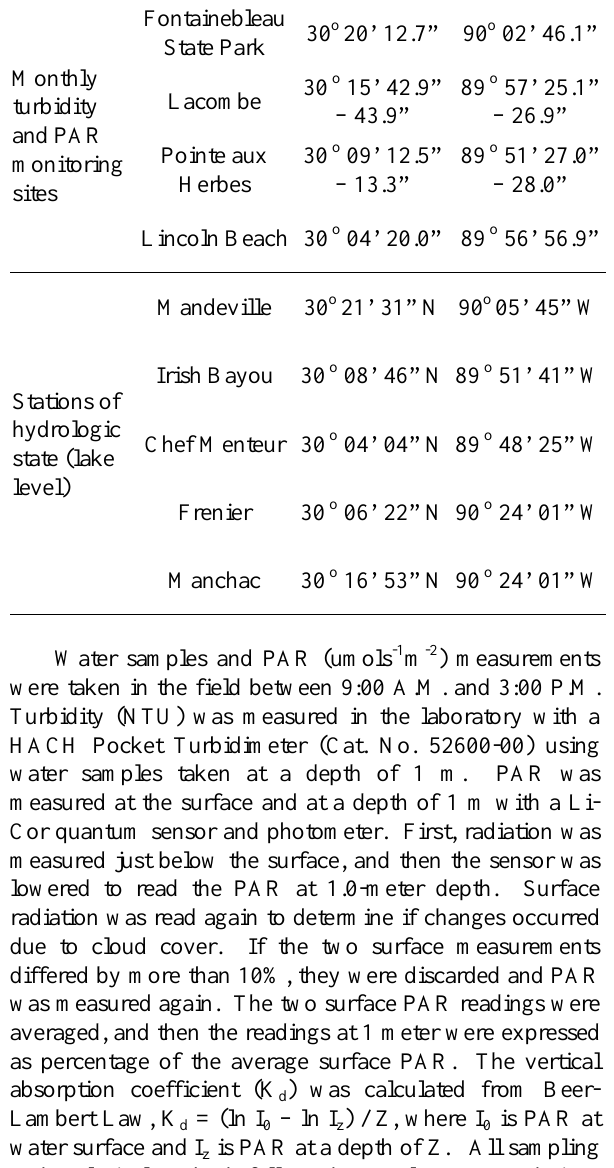
Figure 1: The map of Lake Pontchartrain, Louisiana, USA. Monthly PAR-turbidity monitoring sites are indicated.